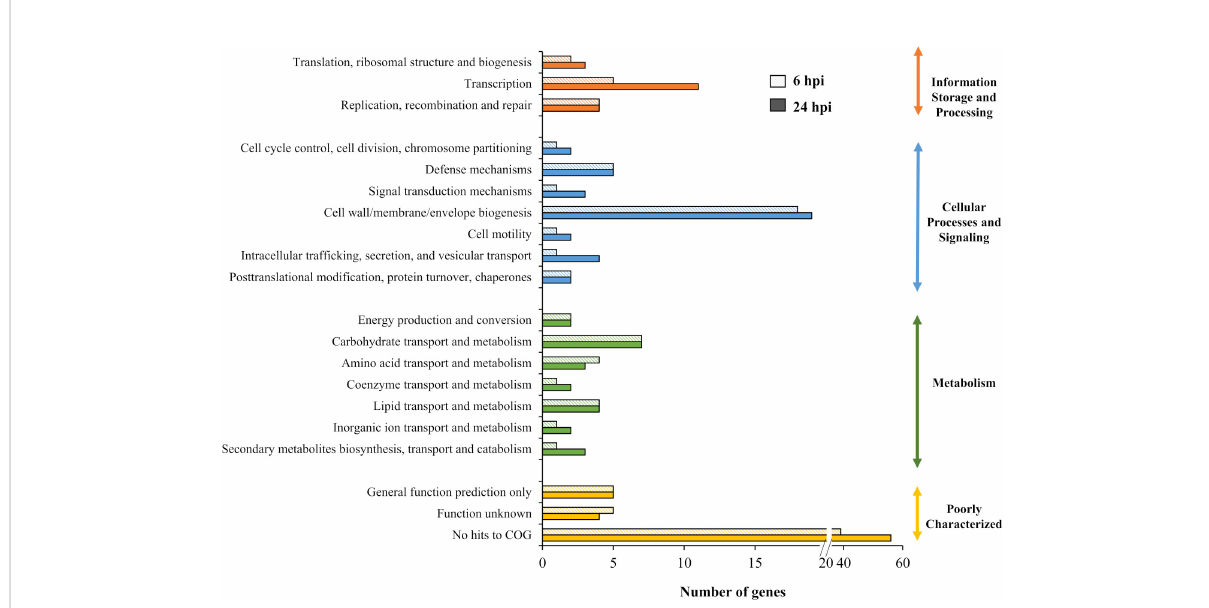
FIGURE 5 Distribution of genes required for B. pseudomallei survival in vivo based on COG functional category. The number of genes identi fi ed for each category was plotted for in vivo output pools collected at 6 and 24 hours post-infection